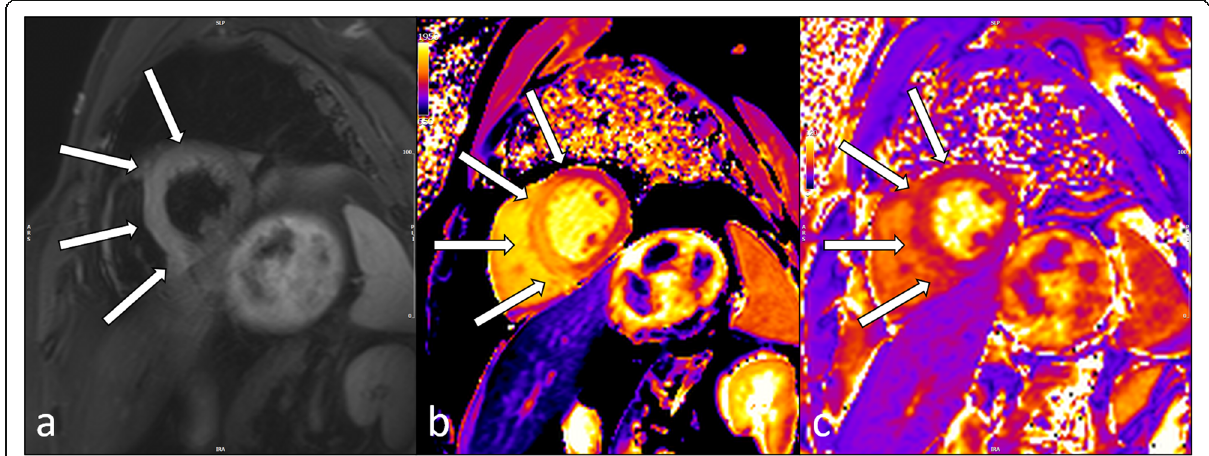
Fig. 2 Thirty-two-year-old man with acute anteroseptal myocardial infarction (same patient as in Fig. 1). T2-STIR image shows excessive edema ( a , white arrows), corresponding to increased native T1 ( b , white arrows) and T2 ( c , white arrows) relaxation times in the affected myocardium. T2-STIR, T2-weighted short-tau inversion